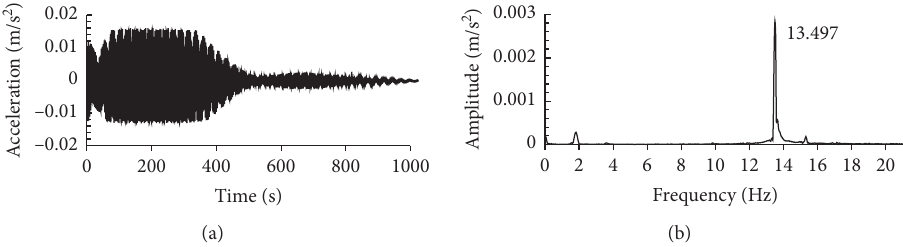
Figure 10: (a) Acceleration time-history curve of suspender without additional mass; (b) frequency spectrum without additional mass.